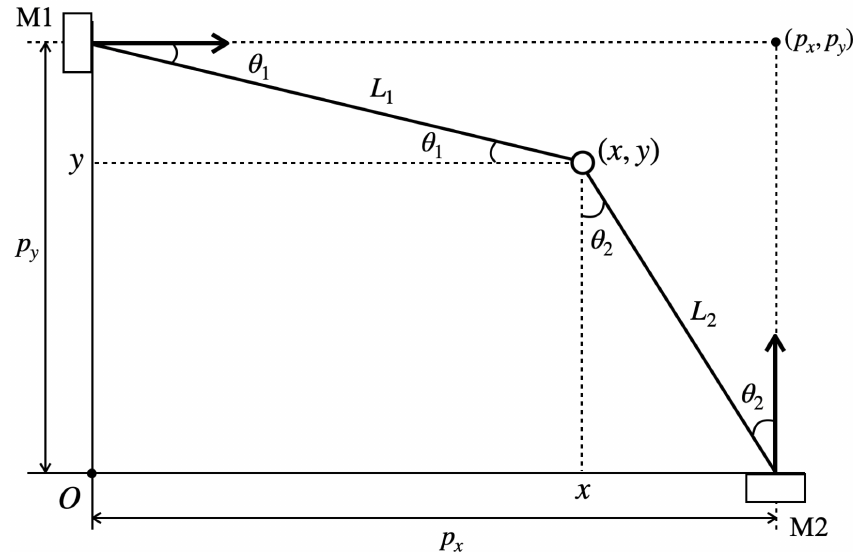
Figure 2. Arrangement of two microphone arrays M1 and M2 for position